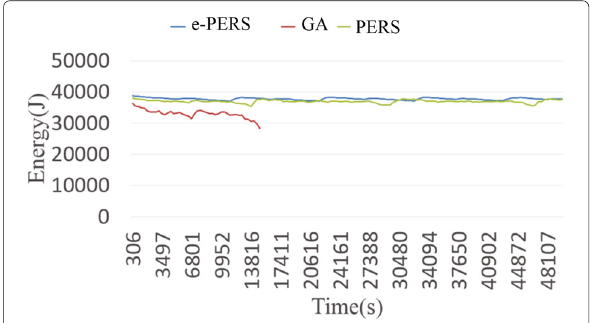
out of energy and coverage holes occurs. On the contrary, PERS and e-PERS proposed in the paper do not result in a coverage hole until the end of the simulation. It reveals that the proposed schemes, PERS and e-PERS, can effec- tively avoid the occurrence of coverage hole and sustain the network lifetime.